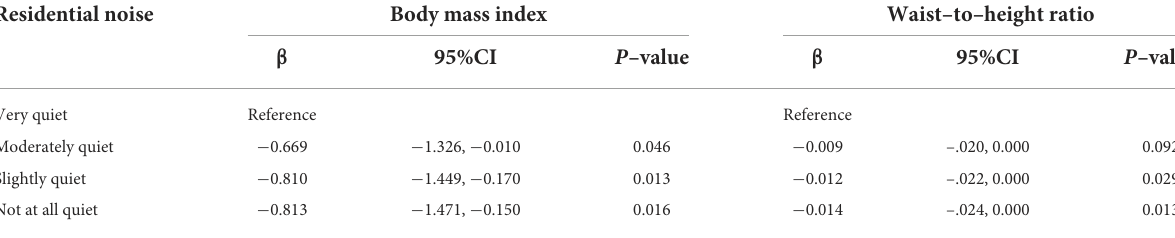
TABLE 3 Associations of self-reported noise exposure with body mass index and waist-to-height ratio.